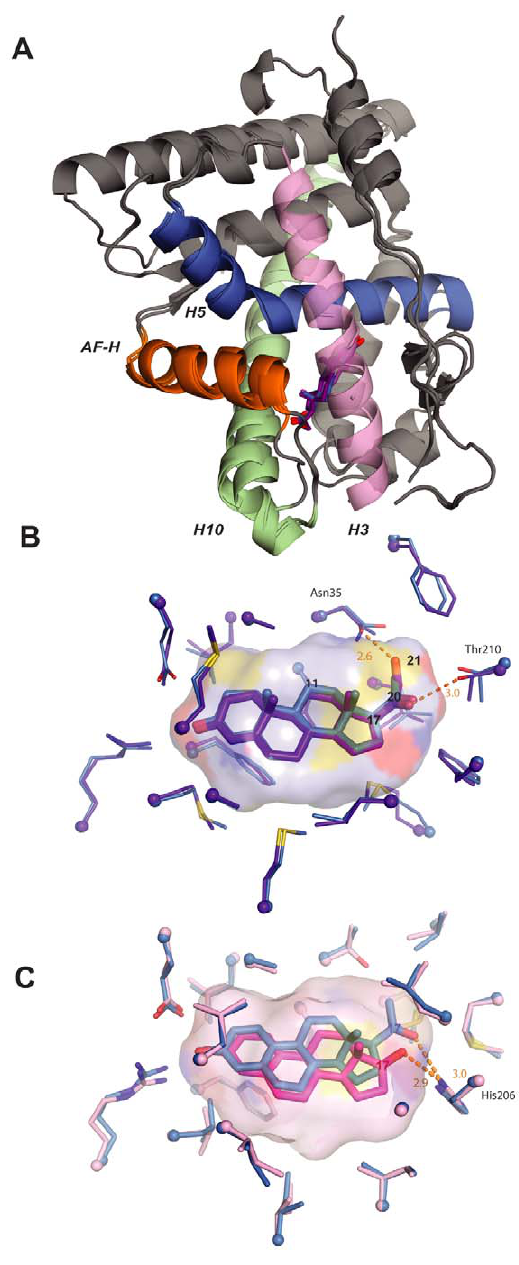
Figure 4. Structural causes of minimal specificity. A, X-ray crystal structures of AncSR2 with progesterone (blue) and DOC (purple) are superimposed. Ligands are shown as sticks. Helices making major ligand contacts and the activation-function helix (AF-H) are shown in contrasting colors. B, Structural causes of promiscuity in AncSR2. The ligand cavity of the AncSR2-progesterone structure, shown as a surface, has adequate volume to accommodate the 21-hydroxyl of DOC. Ligand contacts in the crystal structures of AncSR2 with progesterone (blue) and DOC (purple) are shown. Thick sticks, ligand; thin sticks, side chains that contact ligand; balls, a -carbons. Steroid carbons 11, 17, 20, and 21 are numbered. Hydrogen bonds are shown as orange dotted lines. C, Structural basis for promiscuity in AncSR1. Ligand contacts in the AncSR1 model with estradiol (magenta) and NPT (blue) are shown. The cavity of the AncSR1-estradiol complex, which has adequate room to accommodate the 17-acetyl of NPT, is shown. Two side chains between the viewer and the ligand are hidden for